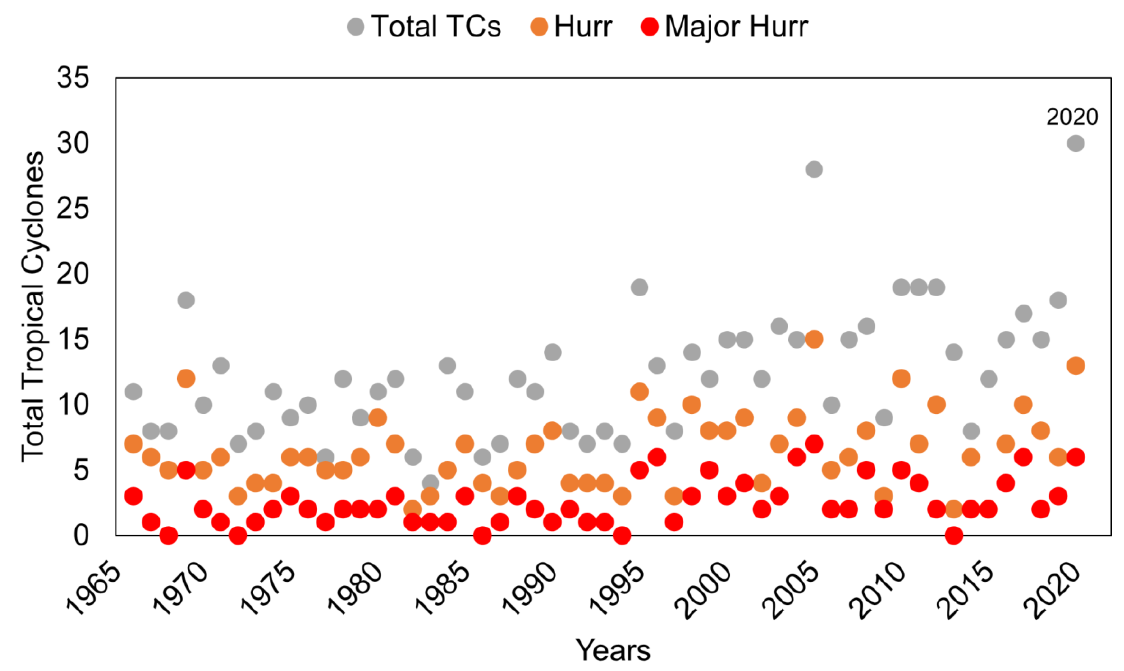
Figure 2. All the tropical cyclones, hurricanes, and major hurricanes that formed in the North At- basin per season for the 1966–2020 lantic basin per season for the 1966 – 2020 period.